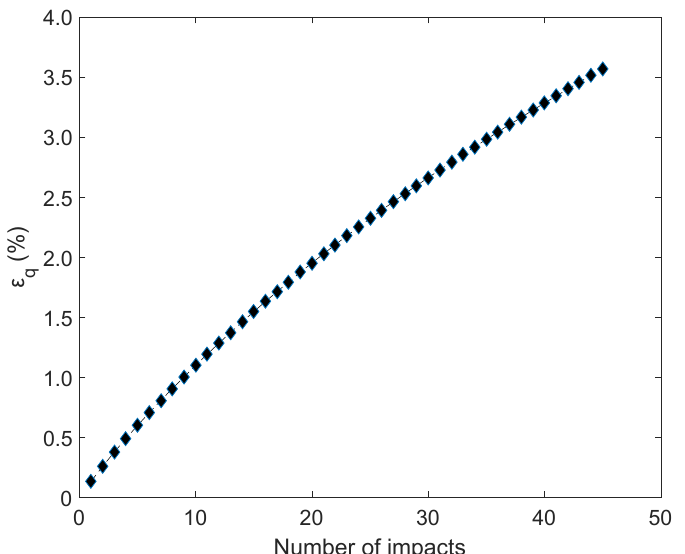
Figure 10. Equivalent plastic strain ( ε q ) of the stainless steel material of Grade 304 of the tidal turbine blade, with respect to the number of